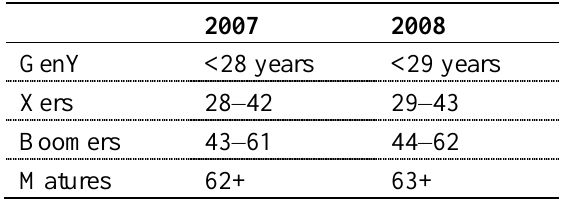
Table 1. Ages for generational cohorts by